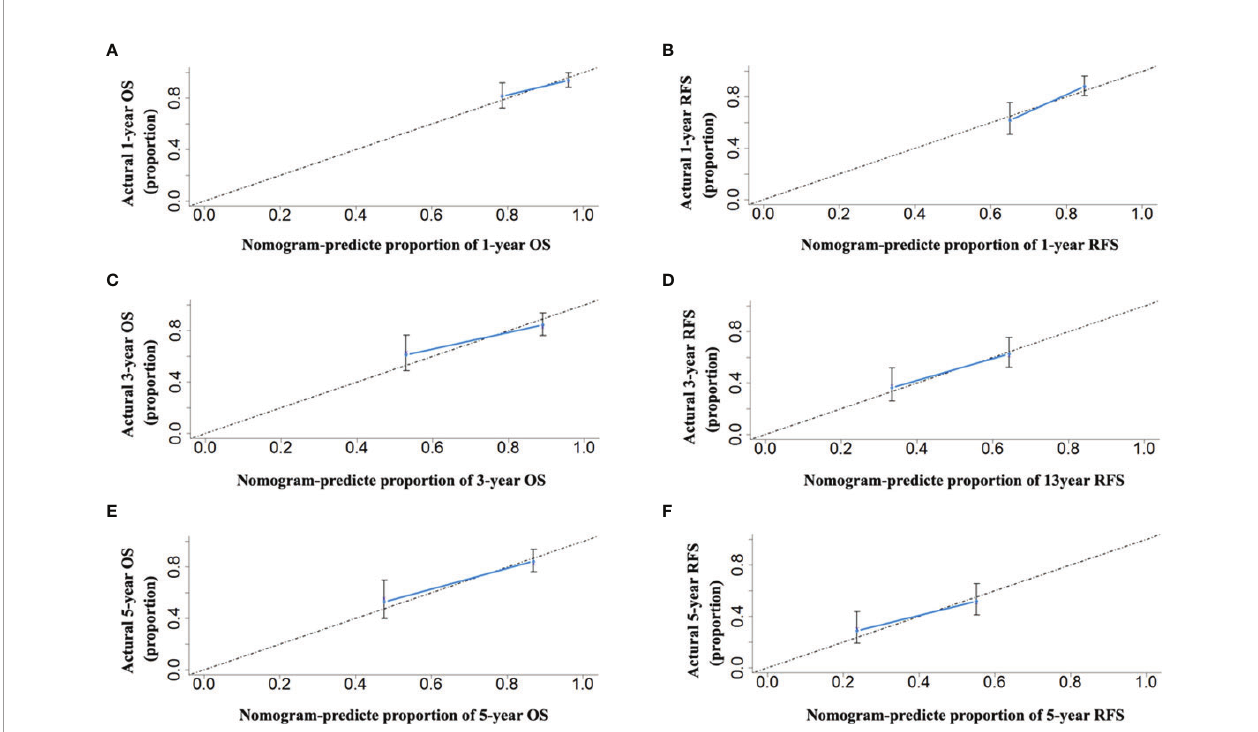
FIGURE 7 | The calibration curves for predicting the 1-, 3- and 5-year OS (A, C, E) and RFS (B, D, F) rates by nomogram prediction and actual observation in patients with HCC in the validation